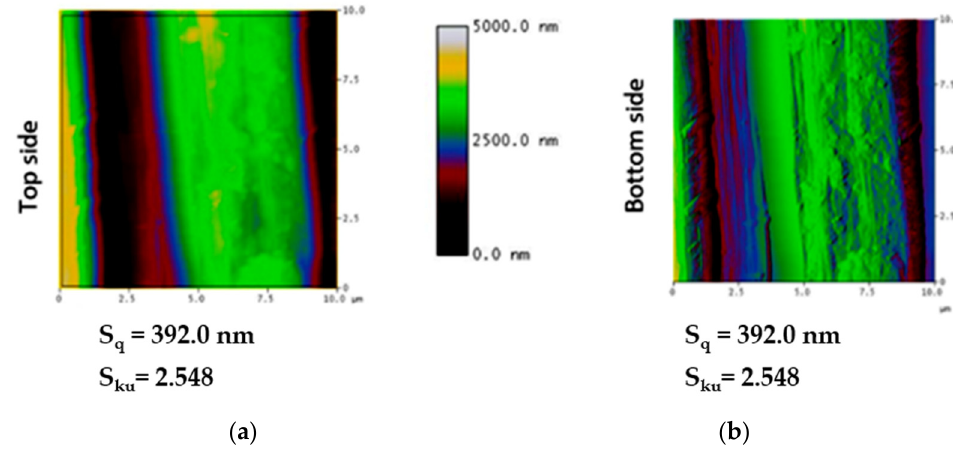
Figure 6. Topography of the stainless-steel filaments: ( a ) top surface and ( b ) bottom surface.